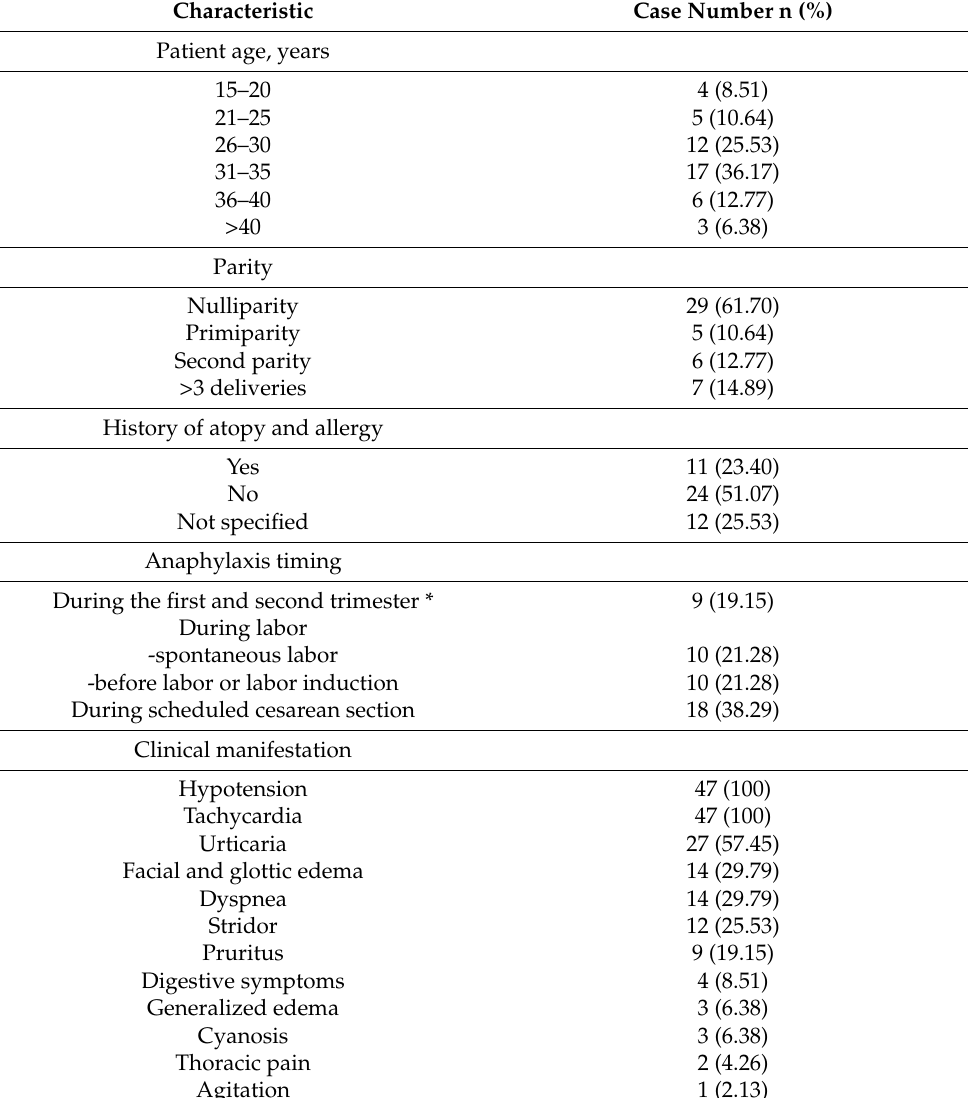
Table 1. Distribution of 47 patients with severe anaphylaxis in 42